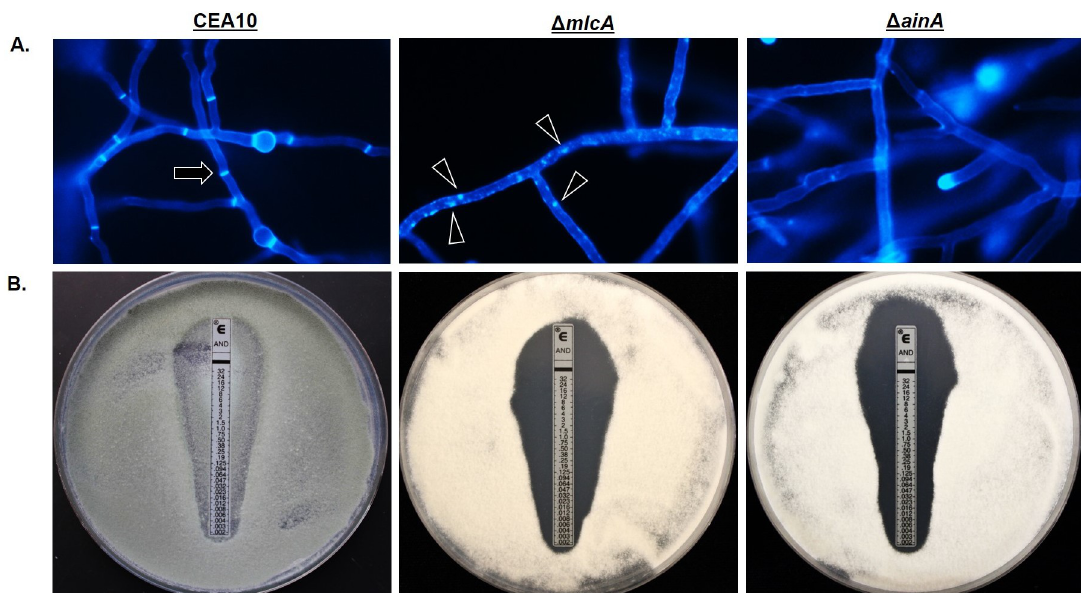
Fig 11. The A . fumigatus genes encoding myosin light chain ( mlcA ) and alpha-actinin ( ainA ) are required for hyphal septation and echinocandin resistance. A) Characterization of septation by CFW staining of the wild type parental strain (CEA10) and the mlcA ( Δ mlcA ) and ainA ( Δ ainA ) deletion mutants. Conidia from each strain were cultured to mature mycelial growth on sterile coverslips submerged in minimal media. Microscopic analysis of CFW-stained cultures revealed fully formed, normal septa in the CEA10 control strain (black arrow), whereas Δ mlcA formed aseptate hyphae with brightly stained puncta of cell wall material and Δ ainA developed only aseptate hyphae. B) Anidulafungin E-test assays for each strain. Note the zone-of-clearance of the Δ mlcA and Δ ainA strains which show the complete absence of